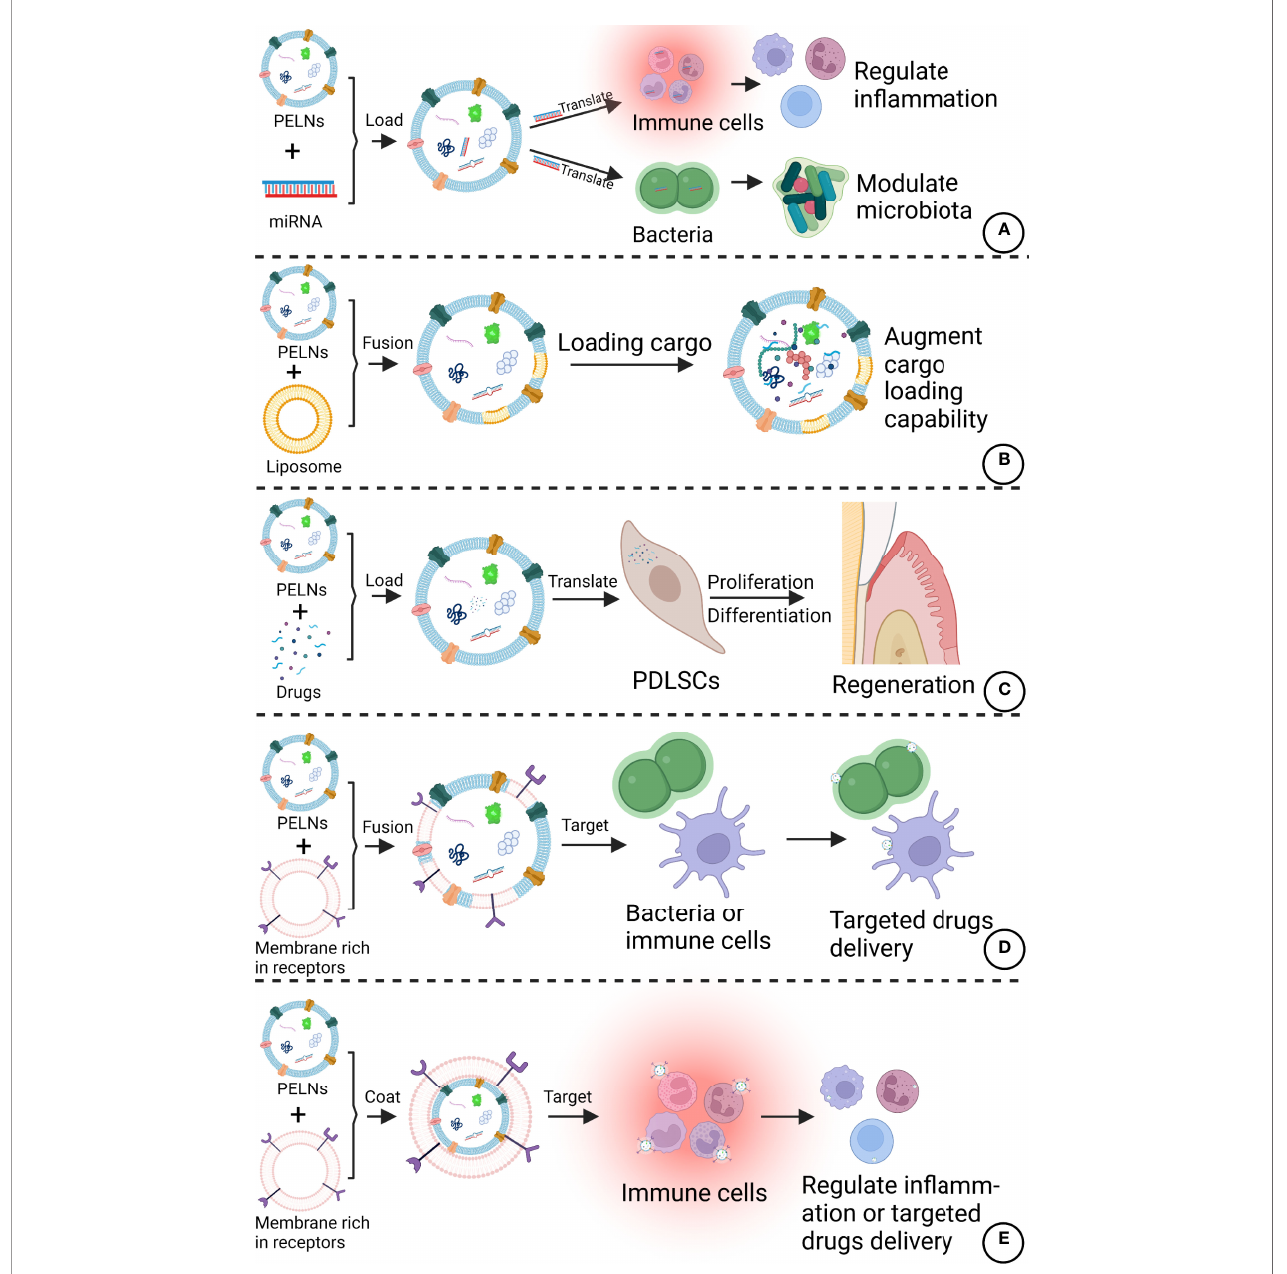
FIGURE 5 | Potential modi fi cations of PELNs that can improve therapeutic ef fi cacy against periodontitis. (A) PELNs can be loaded with speci fi c miRNAs targeting immune cells and bacteria. (B) The amalgamation of liposomes with PELNs could augment the cargo loading capability of PELNs. (C) PELNs can be loaded with the drugs of interest to promote PDLSC functions. (D) PELNs fusion with a membrane rich in special receptors can improve target bacteria or cells in the periodontal region. (E) Coating of membrane rich in special receptors in PELNs can target immune cells. Created with